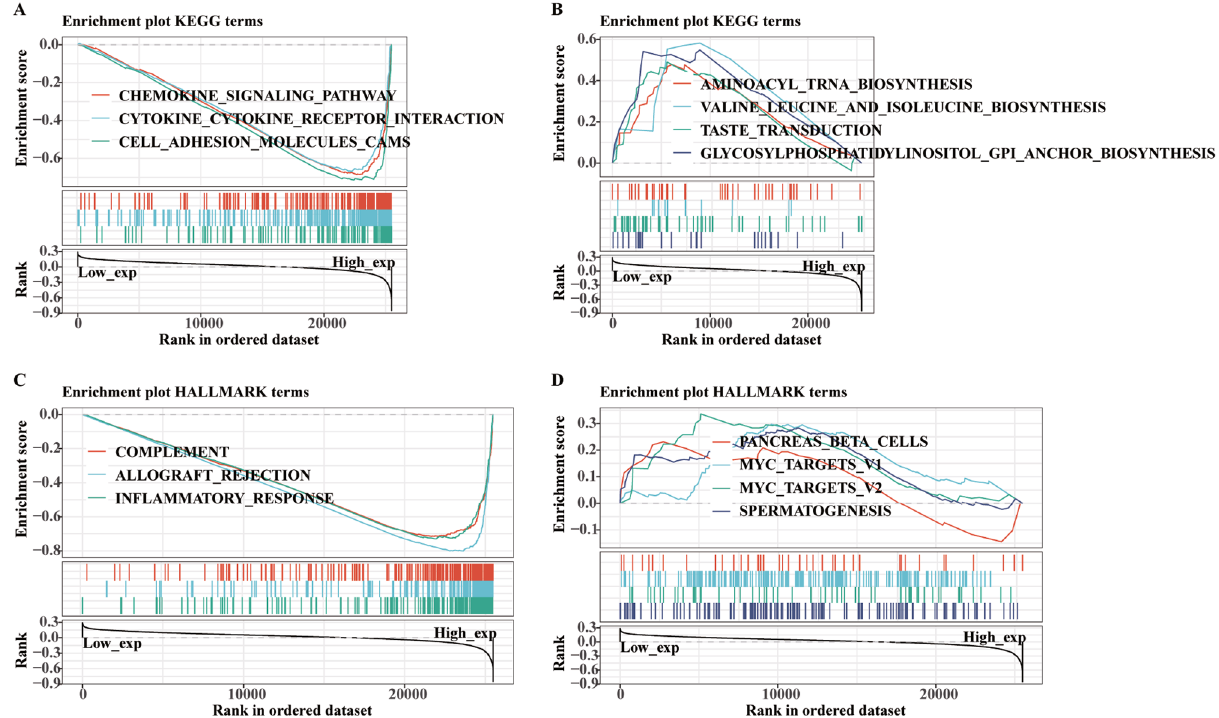
Figure 8. Functional enrichment of KEGG and HALLMARK terms on CD68 based on GSEA in pan-cancer. The top three negative ( A ) and top four positive ( B ) enriched KEGG terms on CD68 in pan-cancer. The top three negative ( C ) and top four positive ( D ) enriched HALLMARK terms on CD68 in